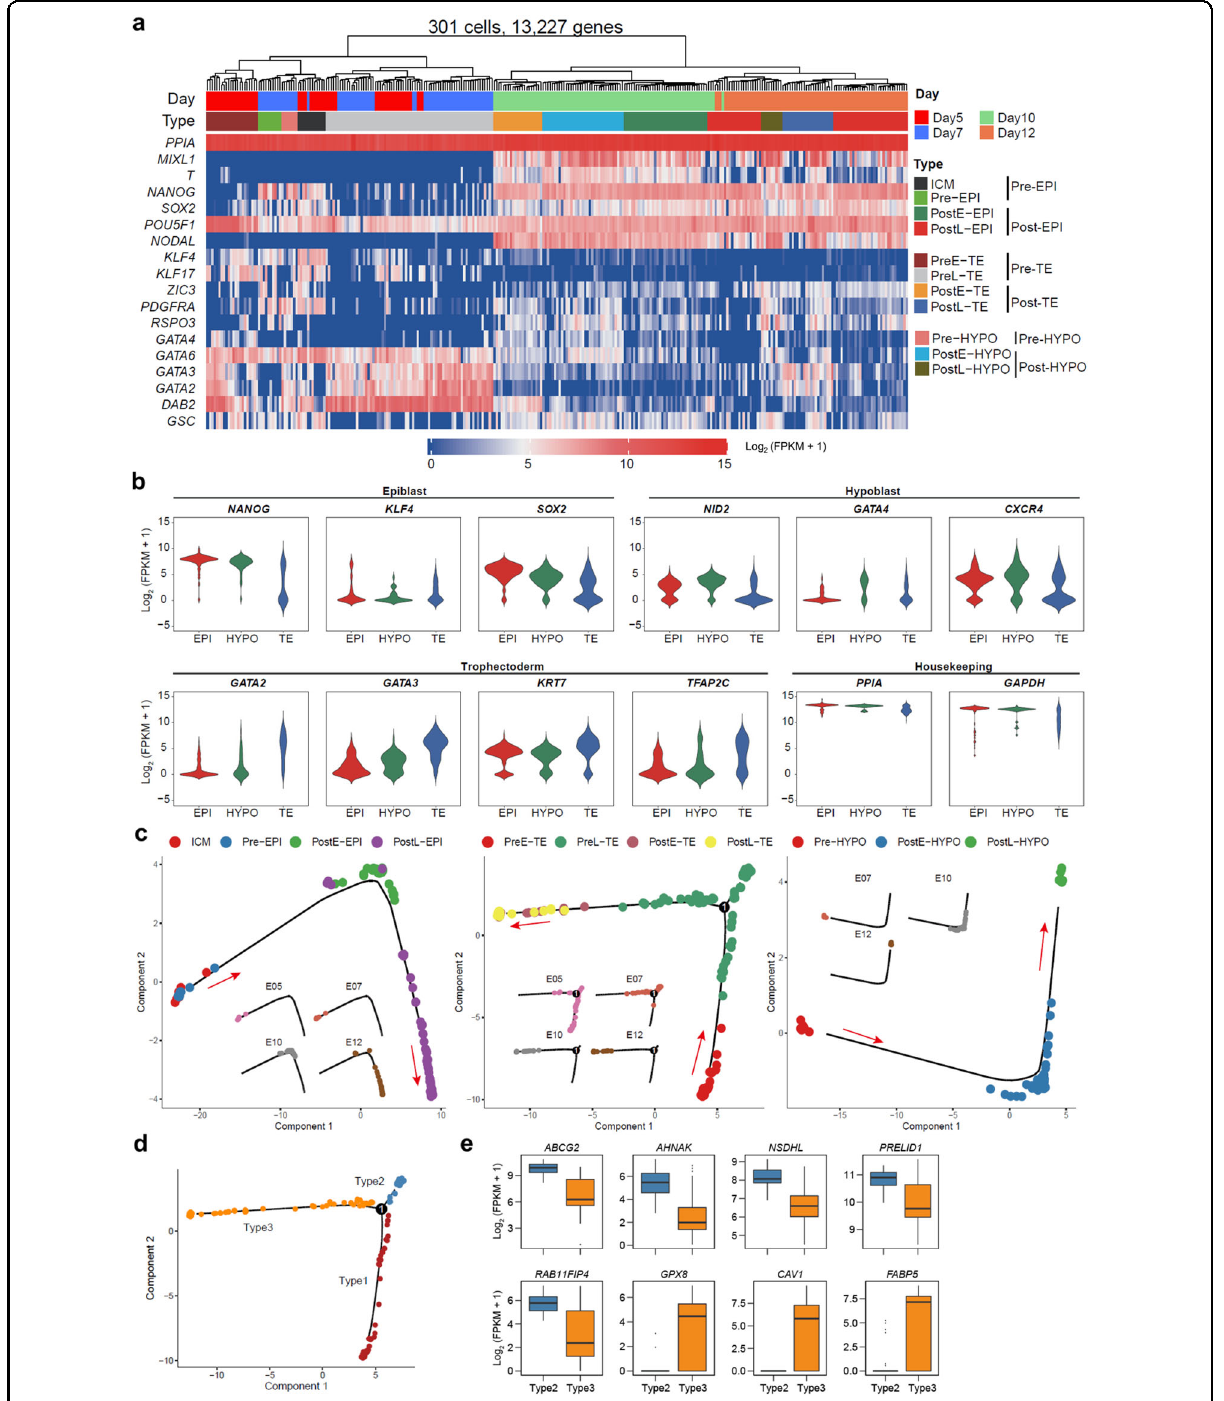
Fig. 2 Lineage speci fi cation in pig embryos. a Unsupervised hierarchical clustering (UHC) with all expressed genes (301 cells, 13,227 genes) and a heatmap of the levels of selected marker genes. Color bars under the dendrogram indicate embryonic days (top) and cell types (bottom), respectively. b Violin plots of the expression of selected lineage speci fi er genes. c The development trajectory of each lineage based on psudotime analysis using Monocle2. d Cell types de fi ned in the developmental trajectory according to the different branches of TE cells in c . e Expression patterns of mural TE- and polar TE-related genes in type 2 and 3 TEs. Stage information was indicated as follows: Pre-, Day 5 or/and Day 7; PreE-, Day 5; PreL-, Day 7; Post-, Day 10 and Day 12; PostE-, Day 10; PostL-, Day